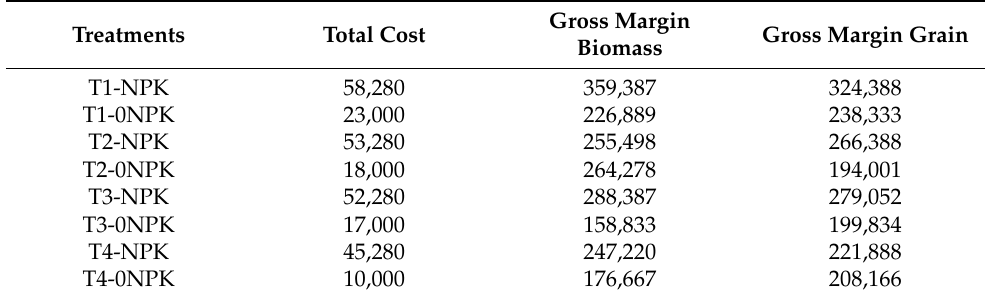
Table 4. Systems economic gains (per hectare) expressed in West African currency, the Franc CFA (XOF).